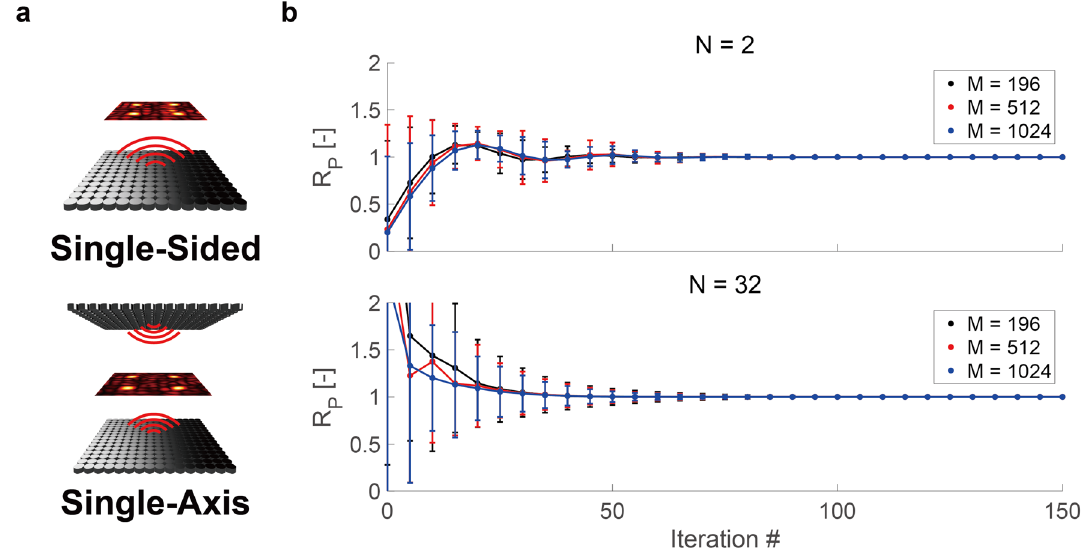
Figure 2. Array configuration and the convergence plot. ( a ) Configuration of single-sided and single-axis PATs. ( b ) Convergence of optimisation function L by the iteration number, control point number (N), and transducer number (M). The convergence is evaluated by R p . The data point and the error bar show the mean and standard deviation of R p , respectively, for the population of randomised 1000 sets of control points. Image created using MATLAB 2020a Update 4 (https:// www. mathw orks. com/ downl oads/), Adobe Illustrator 24.2.1 (https:// www. adobe. com/ produ cts/ illus trator. html), and Autodesk Fusion 360 ver. 2.0.9313 (https:// www. autod esk. com/ produ cts/ fusion- 360/ overv iew? term=1-